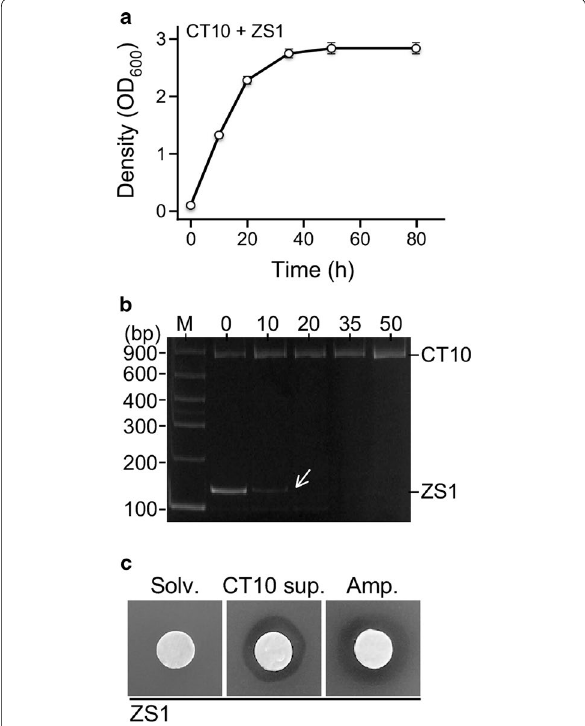
Fig. 2 Alcaligenes sp. CT10 antagonizes against Pseudomonas sp. ZS1. a Growth curve of the mixed CT10 and ZS1 cultures. b Dynamic change of CT10 and ZS1 populations in mixed culture. Arrow indicates the point that the population diminished. c Plate halo assay showing that the growth of ZS1 is inhibited by supernatant extract derived from CT10 cultures